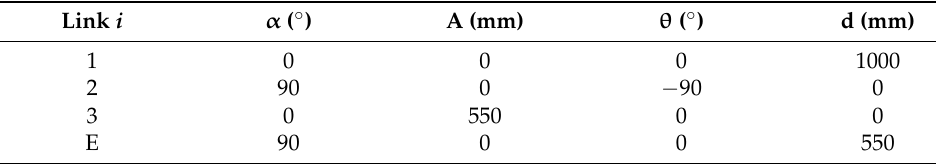
Table 3. Obstacle Setting.